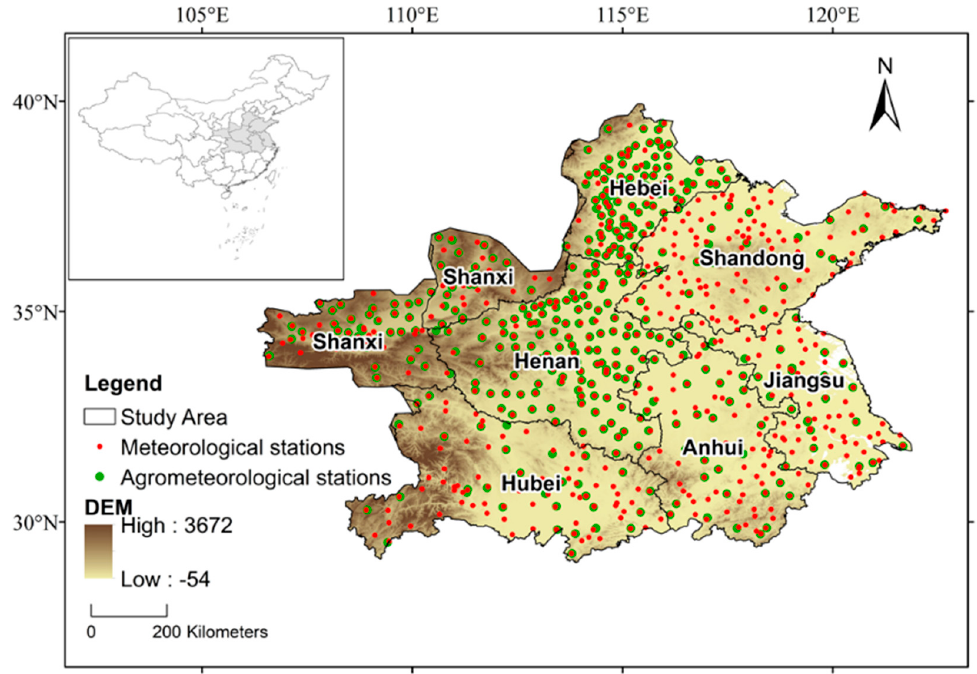
Figure 1. Study area and locations of meteorological and agrometeorological